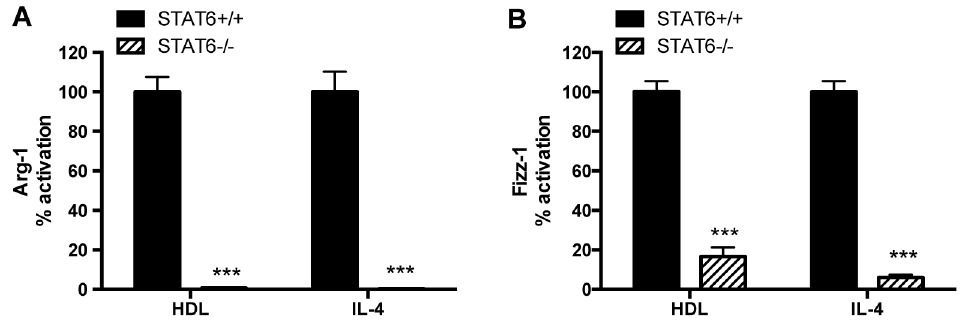
Figure 4. STAT6 inhibition affects macrophages alternative activation by HDL. BMDM were isolated from STAT6 +/+ (black bars) and STAT6-/- (hatched bars) mice and were stimulated for 6h with HDL (50μg/mL) or IL-4 (10ng/mL). The induction of Arg-1 or Fizz-1 mRNA in the STAT6+/+ cells by HDL was ~3X for each and by IL-4, ~1800 or 3300, respectively; these values were set to 100%. Results are representative of three independent experiments. Asterisks indicate statistically significant differences compared to corresponding STAT6 +/+ conditions (***p<0.001). doi: